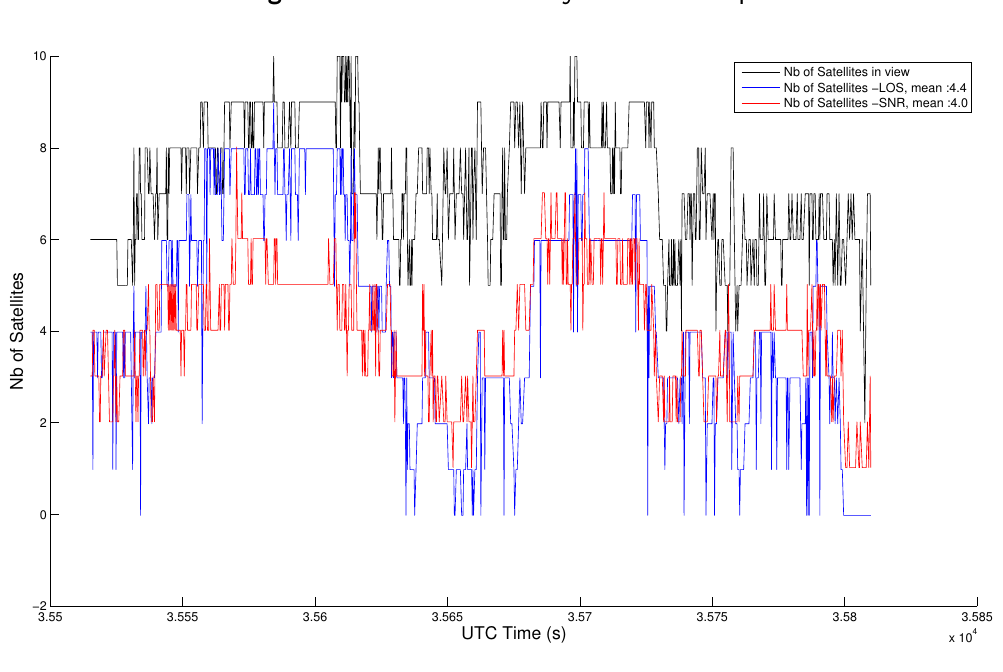
Figure 7. Satellite visibility in